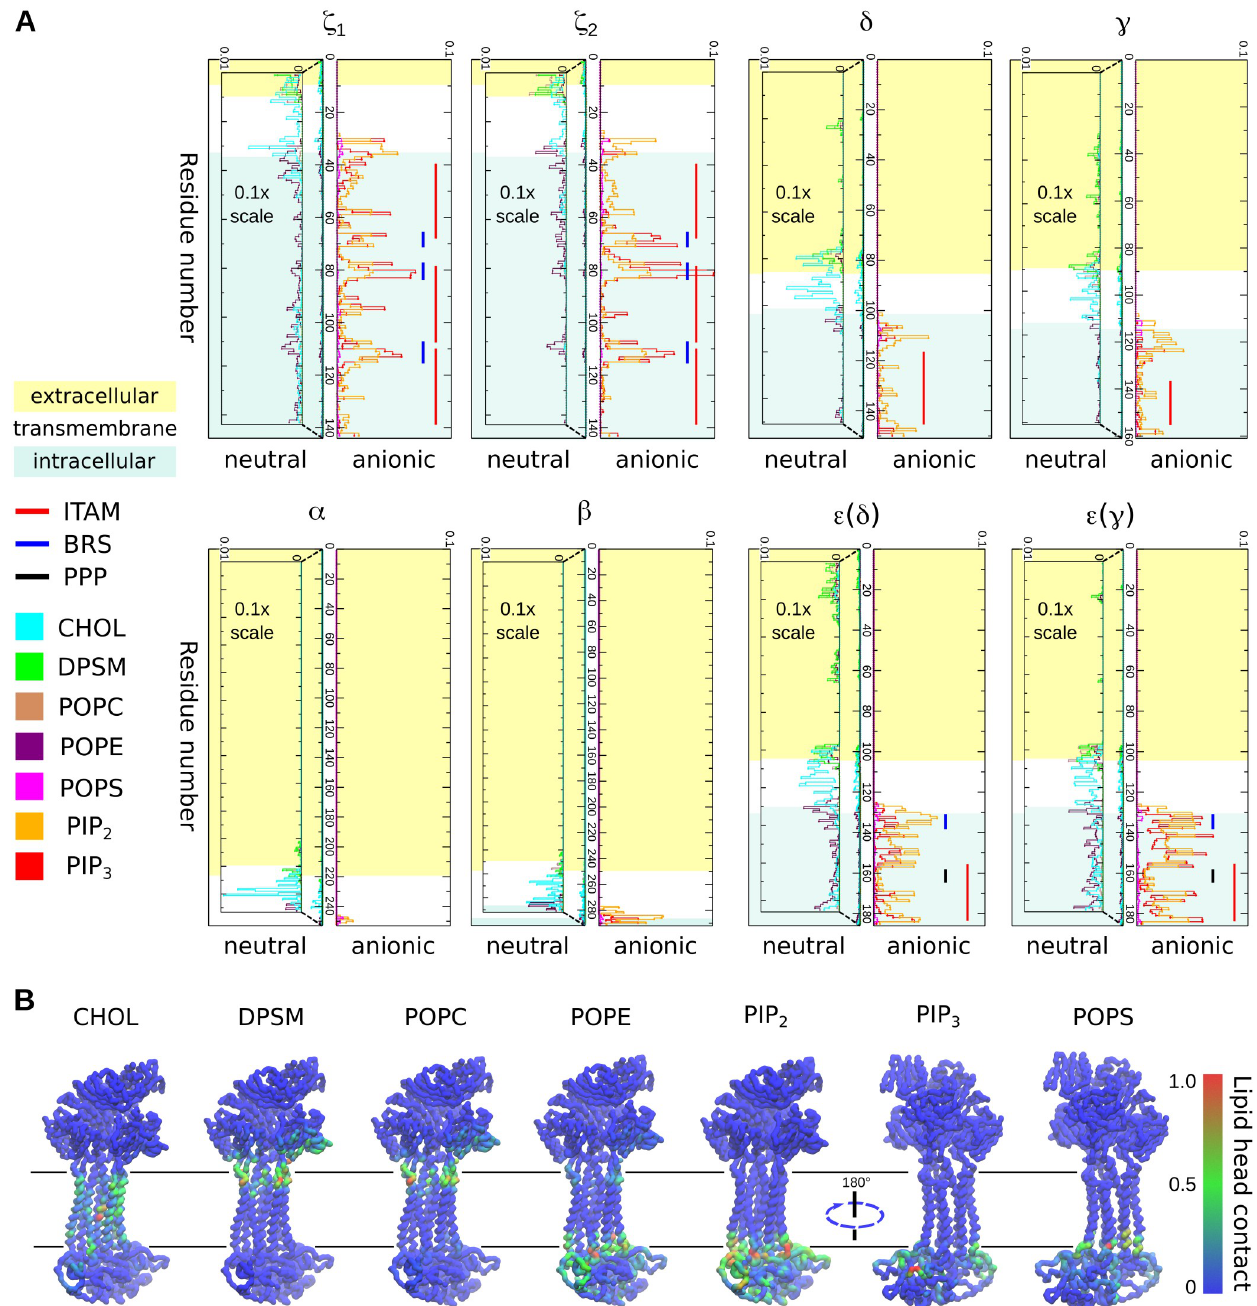
Fig 4. Interactions of the TCR-CD3 with lipid headgroups. (A) Normalized number of contacts of each full-length TCR-CD3 subunit with lipid headgroups. The normalization (N) is done by dividing the number of lipid contacts of each residue (n1) by the number of the specific lipid in the bilayer (n2) and by the number of simulation frames (n3) i.e. N = n1/n2/n3. Interactions of each TCR-CD3 subunit with anionic lipids are shown on the right whereas those with neutral lipids are shown on the left. The scale of non-anionic interactions was magnified 10 times (scale: 0 to 0.1) for clarity. The ITAMs (red lines) of z and all CD3 subunits, the BRS motifs (blue lines) of CD3 ε and z subunits, and poly-proline motifs (black lines) of the CD3 ε subunits are also indicated. (B) Contacts of the TCR-CD3 with each lipid headgroup type are normalized separately on a scale of 0 to 1 and mapped as a colour gradient (blue: low, green: medium, red: high) on the TCR-CD3 structure extracted from the end of a simulation.